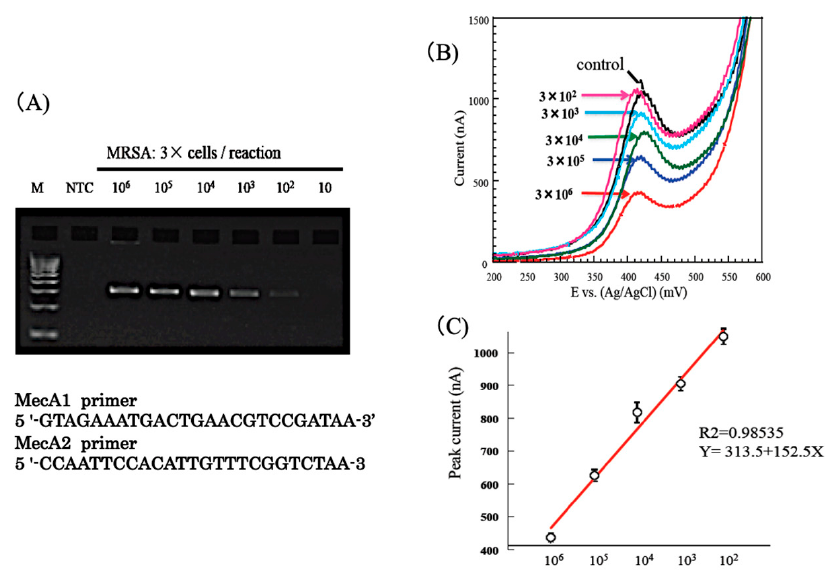
Figure 13. Monitoring of nosocomial MRSA bacteria [19]. ( A ) Electrophoresis of PCR-amplified genes encoding MRSA; ( B ) Cyclic voltammograms (0–600 mV) were obtained with PCR amplified genes with different initial bacterial number; ( C ) Calibration of bacterial number with peak current.